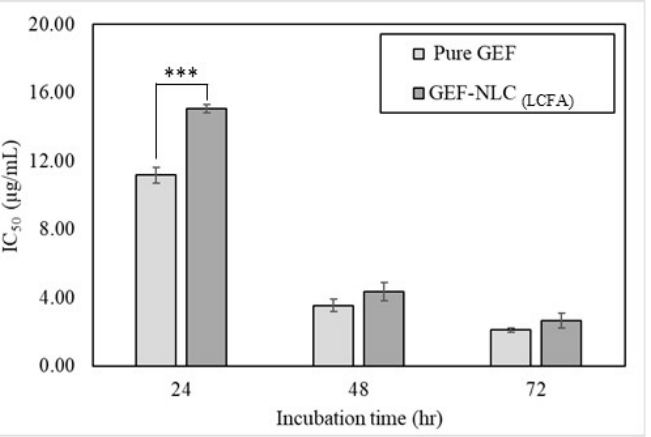
Figure 11. Effect of plain NLC, pure GEF, and GEF-NLC (LCFA) on A549 cell viability after ( A ) 24 h, ( B ) 48 h, and ( C ) 72 h, respectively. Data are expressed as mean ± SD, N = 3.